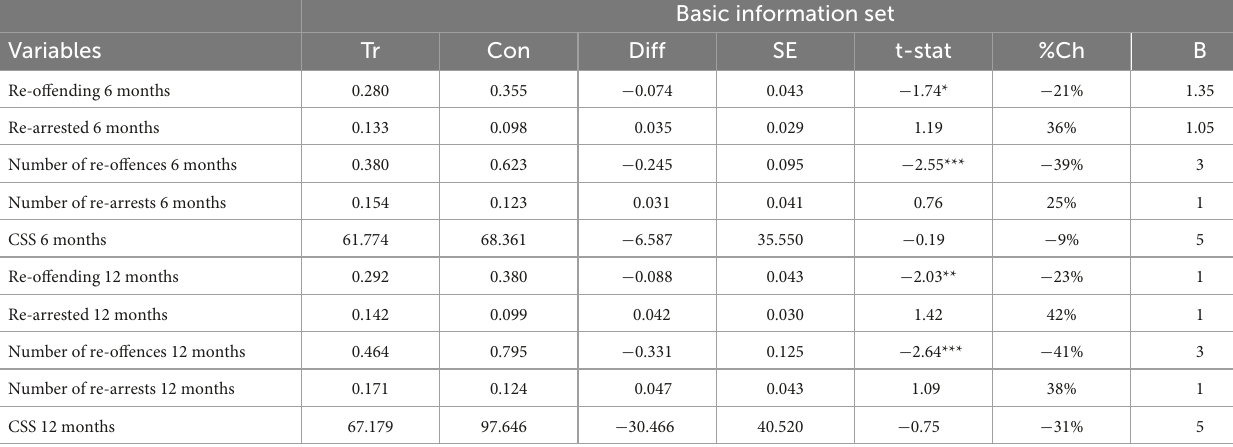
TABLE 10 Propensity score matching results (Hampshire